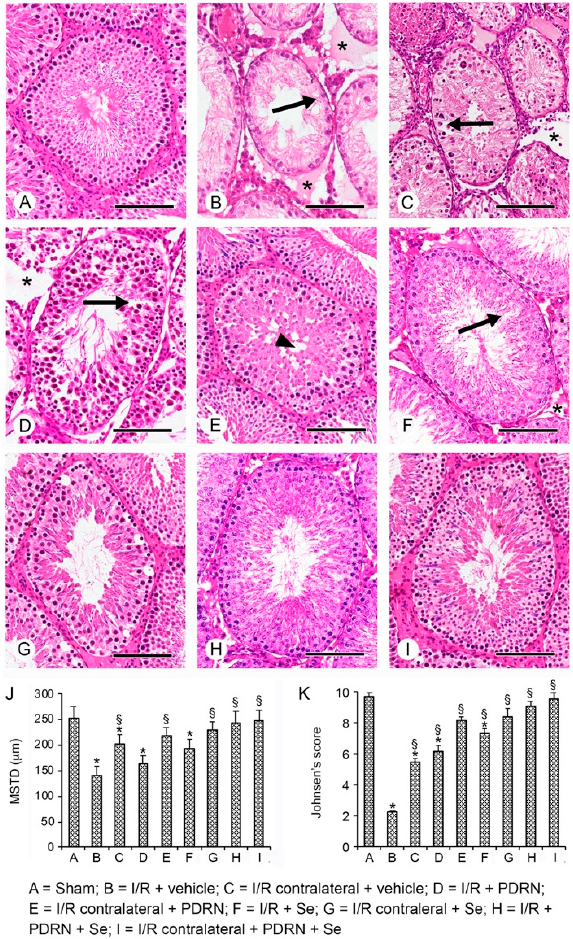
Figure 2. Histological findings in the seminiferous tubules of the different groups of rats (H&E stain). ( A ) Sham rats show normal morphology. ( B ) In I/R + vehicle rats, degenerative changes in the germinal cells (arrow) and edema of the extratubular compartment (*) are evident. ( C ) CL testes of I/R + vehicle rats show a germinal epithelium with only spermatogonia, isolated spermatocytes (arrow), and interstitial edema (*). ( D ) In the testes of I/R + PDRN rats, elongated spermatids are present in the germinal epithelium, even if some intercellular clefts (arrow) are evident; mild edema is demonstrated in the extratubular compartment (*). ( E ) The CL testes of the same group show a close-to-normal extratubular compartment and a germinal epithelium with isolated, empty zones in the basal position. ( F ) The testes of I/R + Se rats have tubules with peripheral spermatogonia and detached spermatocytes; the extratubular compartment is dilated (*). ( G ) CL testes of the same group show larger tubules, and their lumen is filled with round spermatids (arrowhead). ( H , I ) In the testes of I/R + PDRN + Se rats and the CL testes of the same group, no evident morphological changes are recognized in both the tubular and the extratubular compartments. ( J ) Histogram of the mean seminiferous tubule diameter (MSTD) in the different groups of rats (mean ± standard deviation). ( K ) Histogram of the Johnsen score in the different groups of rats (mean ± standard deviation). * p ≤ 0.05 versus sham group; § p ≤ 0.05 versus I/R rats (Scale bar: 100 µ